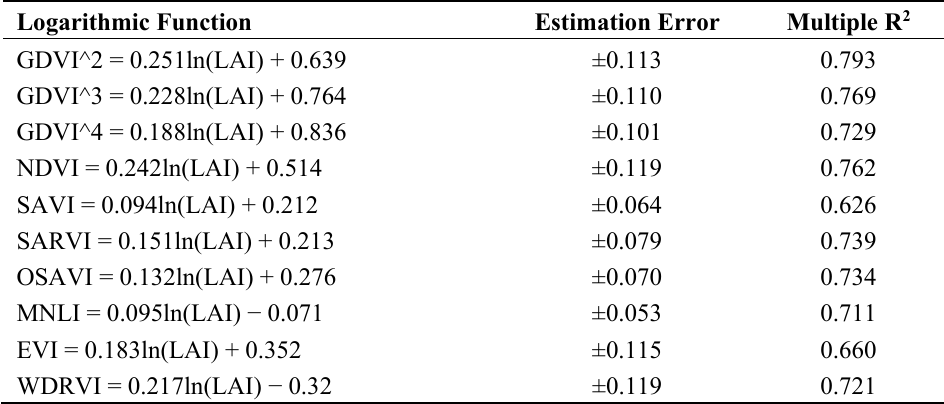
Table 5. Calibrated logarithmic relationships between vegetation indices (VIs) and Leaf Area Index (LAI) from 890 random samples across all land cover types taking the image pair of 1 May 2007 as an example.